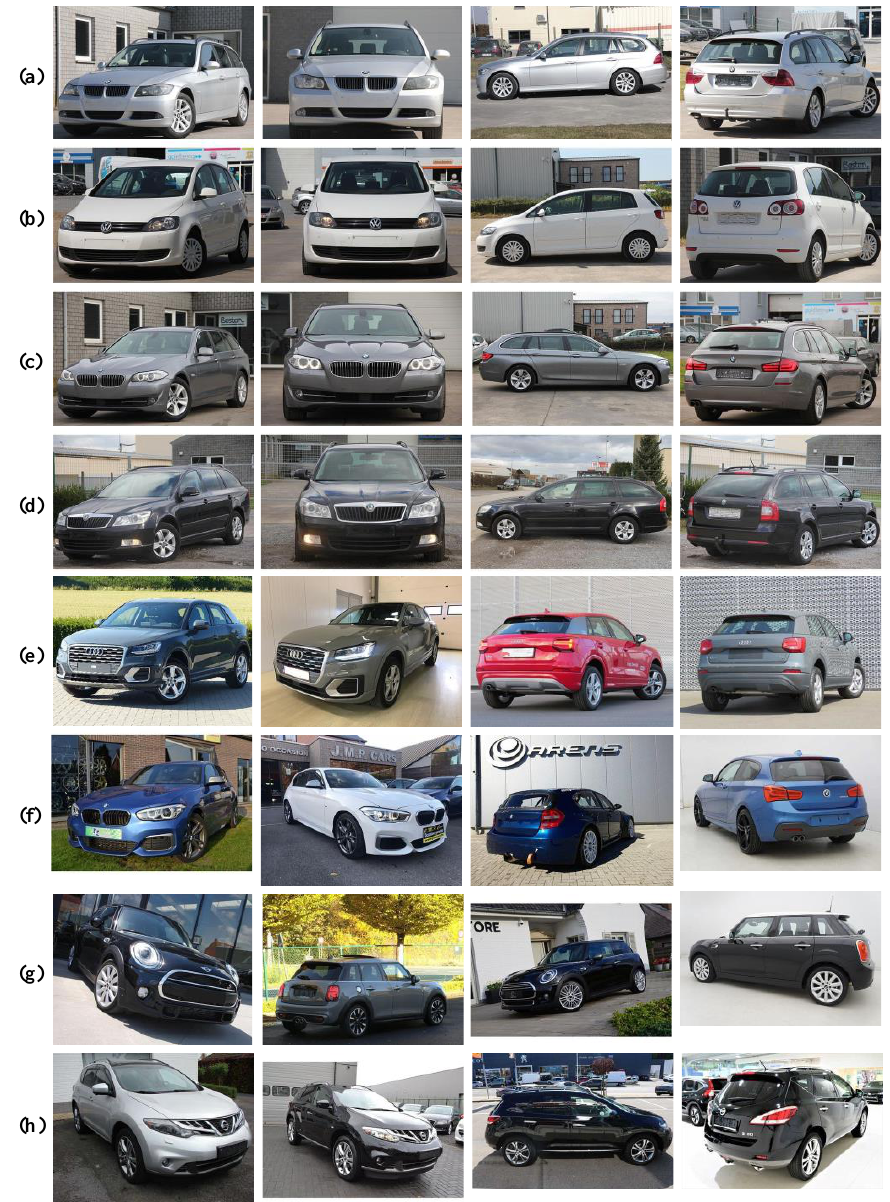
Figure 1. Sample images from the proposed DVMM dataset: ( a ) BMW 3 Series ; ( b ) Volkswagen Golf ;